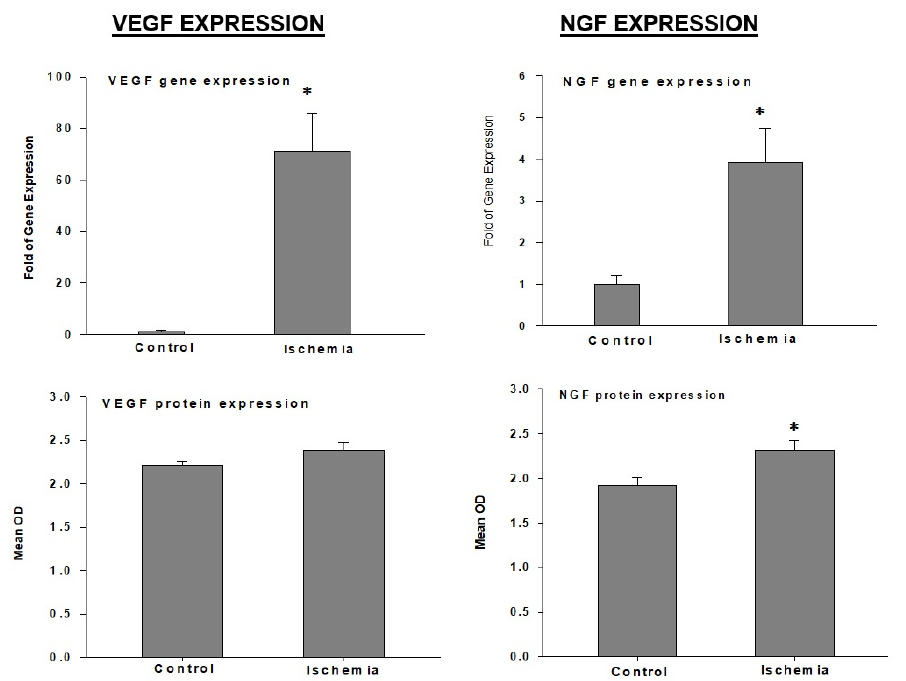
Figure 7. Expression of VEGF and NGF in rabbit bladder tissues. * Indicates significant differences versus control. This figure is taken from our previous publication [6].